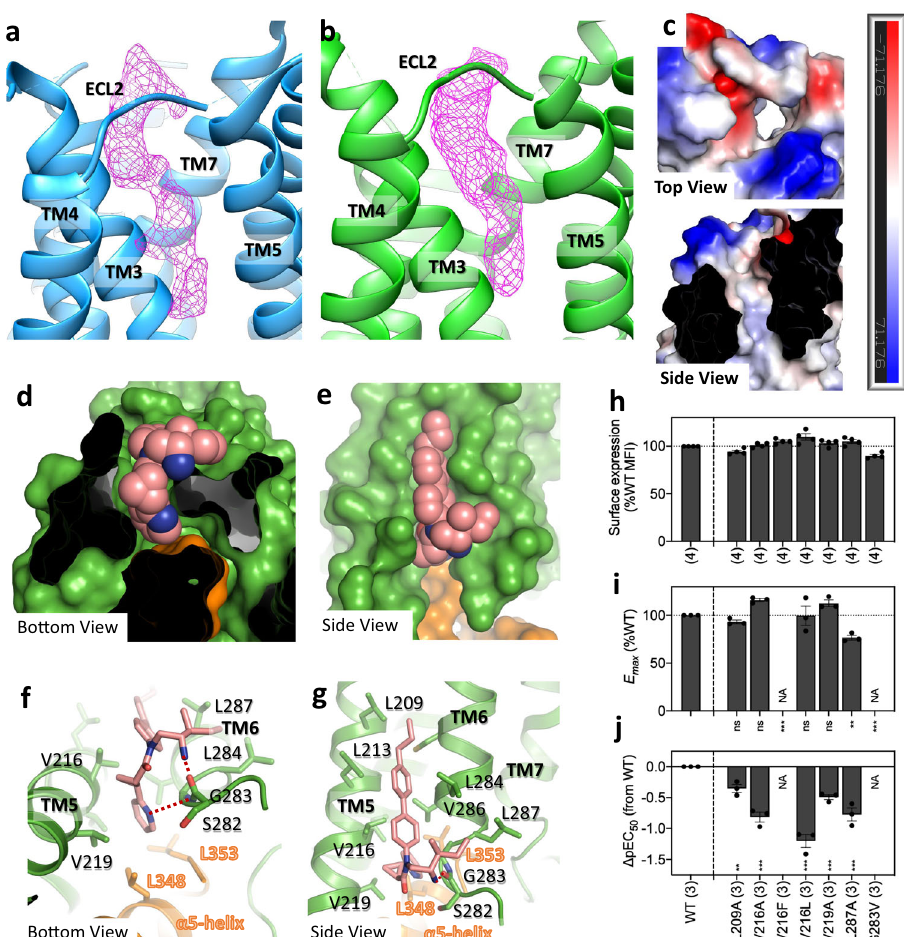
Fig. 2 Orthosteric and allosteric binding sites. a , b The unassigned electron density observed in the canonical orthosteric pocket of GPR88. Blue, structure without 2-PCCA ( a ); green, structure bound to 2-PCCA ( b ). c The charge distribution of the orthosteric pocket is shown in two different views. d , e The molecular surface of the allosteric pocket from bottom ( d ) and side ( e ) views. f , g Detailed interactions between 2-PCCA and the allosteric pocket from bottom ( f ) and side ( g ) views. Polar interactions are highlighted as dashed lines. h – j Cell-surface expression ( h ) and Gi-coupling activity ( i , j ) were analyzed by the fl ow cytometry and the NanoBiT-Gi dissociation assay, respectively. From the concentration – response curves (Supplementary Fig. 4), E max ( i ) and Δ pEC50 ( j ) values relative to the wild type were calculated. Colors in the mutant bars indicate an expression level matching to that of titrated wild type. NA, parameter not available because of lack of the ligand response. Statistical analyses were performed using the ordinary one-way ANOVA followed by the two-sided Sidak ’ s post hoc test with the expression-matched (colored) WT response. ns, p > 0.05; * p < 0.05; ** p < 0.01; *** p < 0.001. Bars and error bars re p resent mean and s.e.m. of 3 independent experiments, denoted as the parenthesis at the bottom of the fi gure panels. Source data are provided as a Source data fi